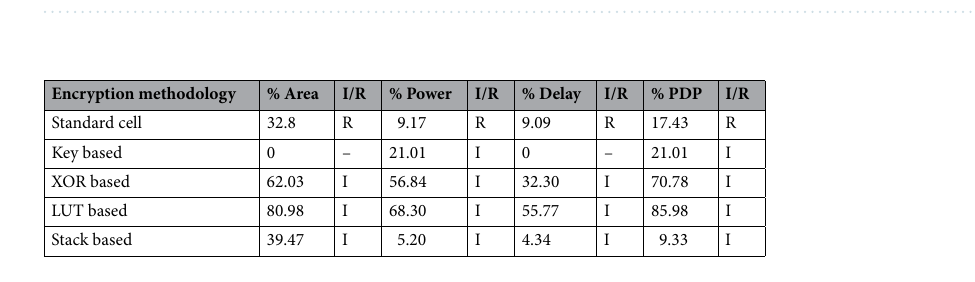
Table 20. % of Changes for NOR gate.